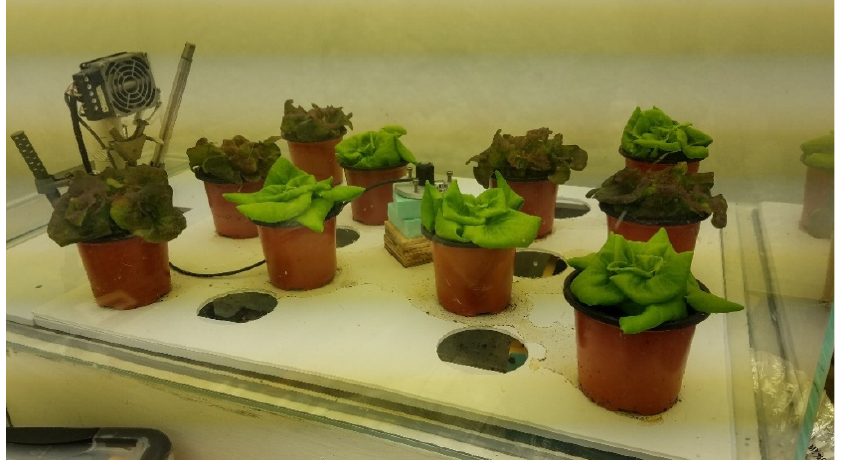
Figure 1. One block of ten lettuce plants housed within a sealed acrylic chamber with a controlled concentration of CO 2 gas.